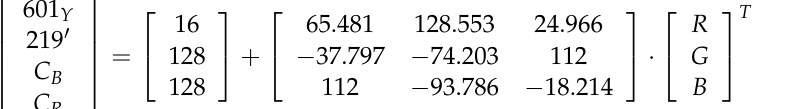
Figure 5. Range sensors’ touch points centralization with their corresponding color pads.